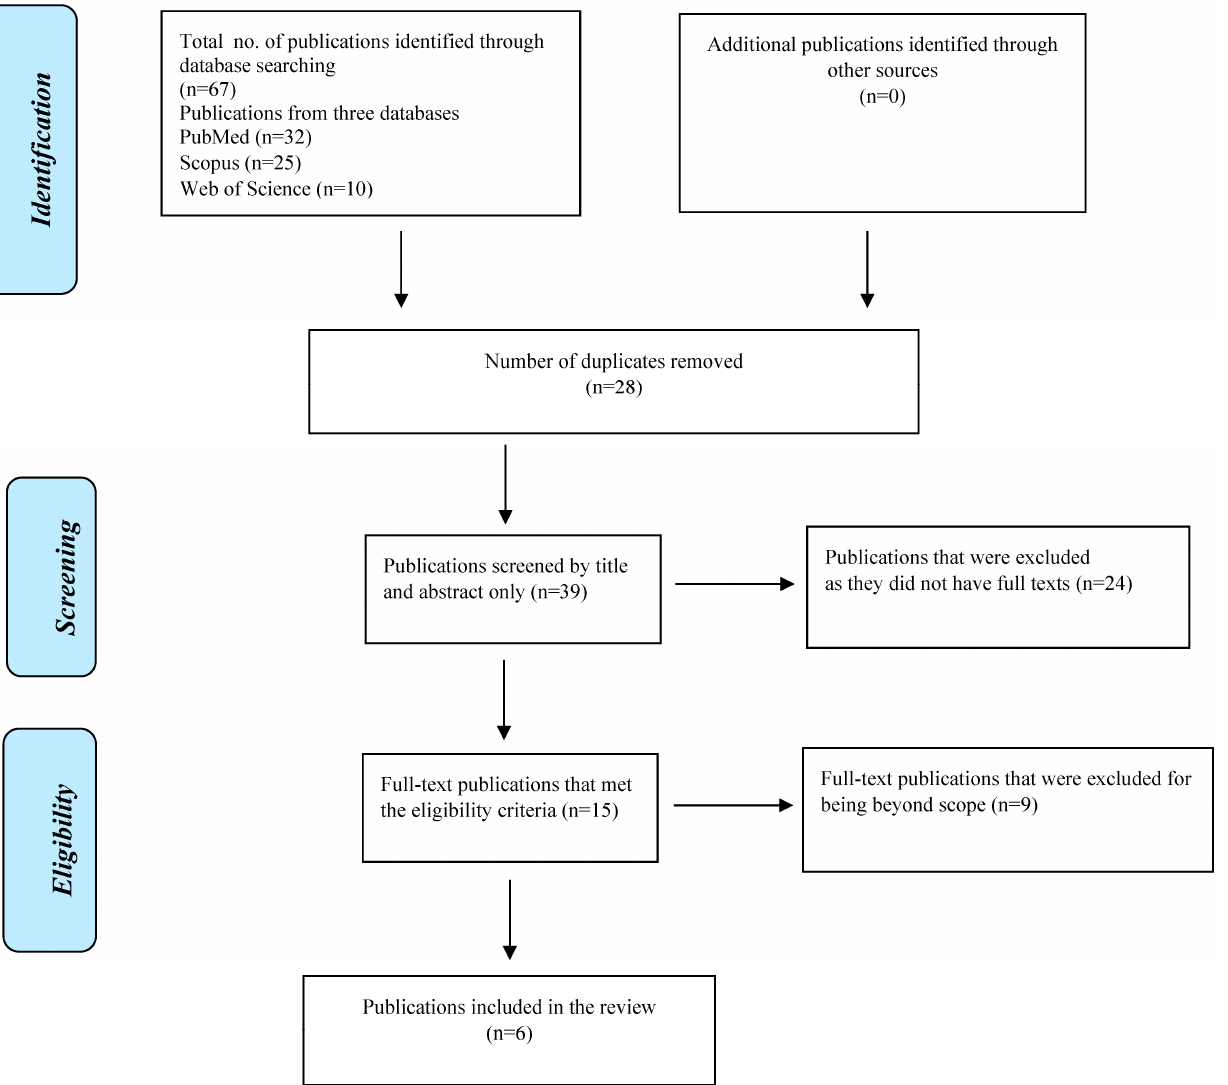
Figure 1. Flow diagram showing the study selection criteria. Table 1. Table showing the eligible papers for analysis of vaccine hesitancy n = 6.